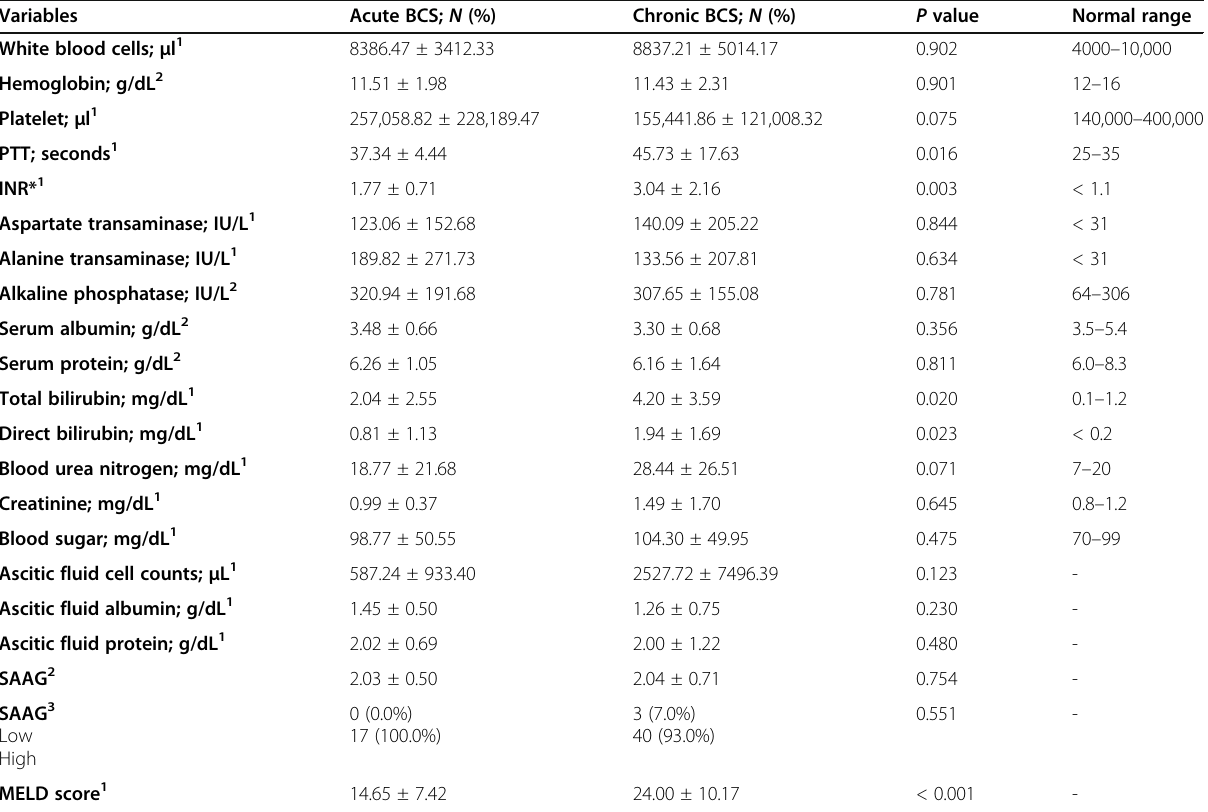
Table 3 Comparison of laboratory parameters between acute ( n = 17) and chronic ( n = 43) Budd – Chiari syndrome (BCS)